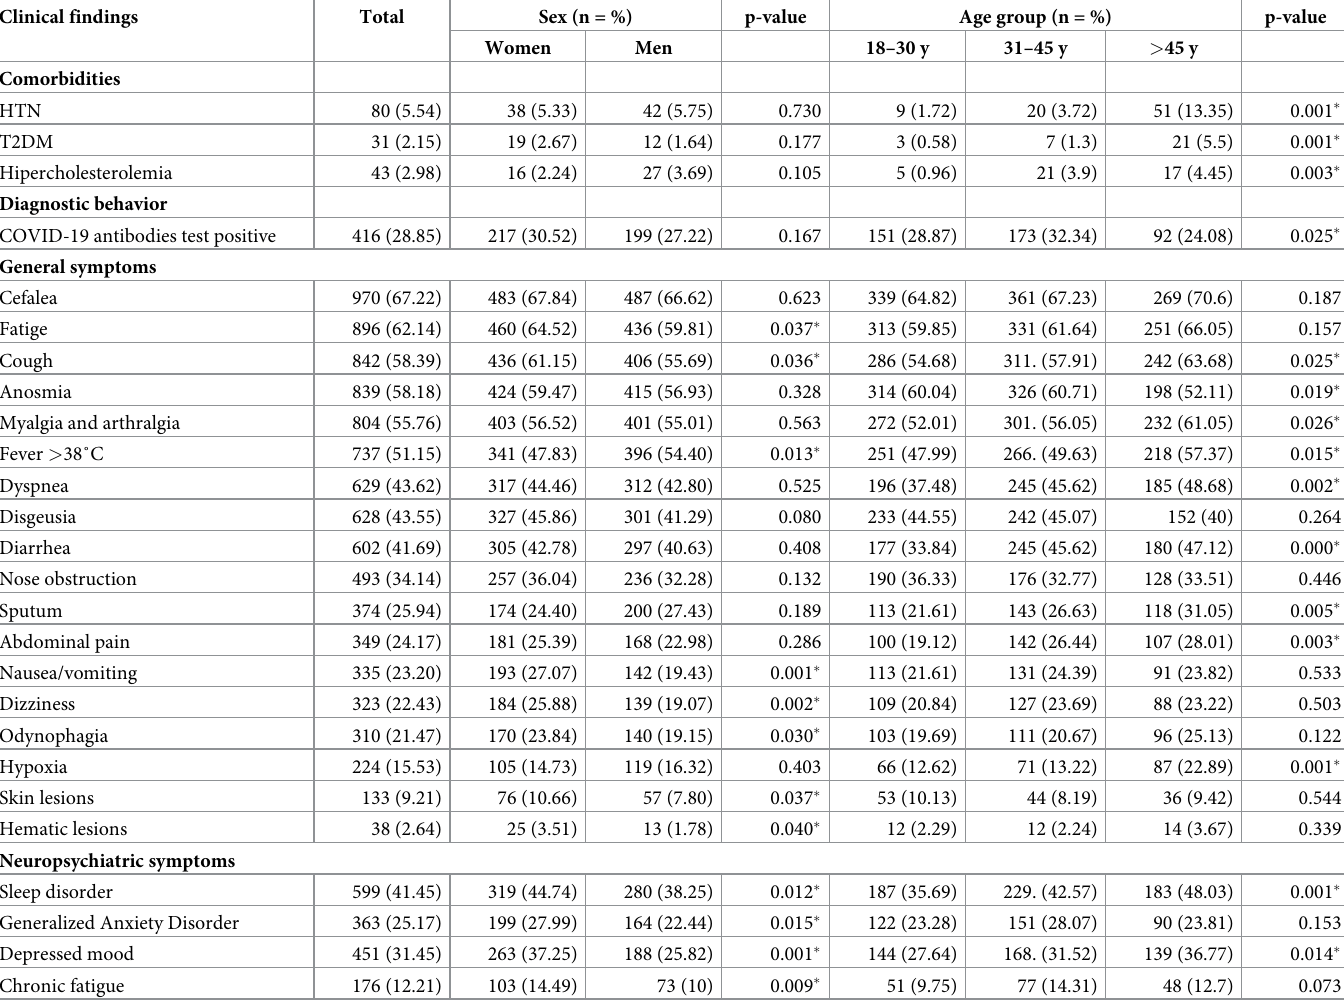
Table 1. Distribution of non-hospitalized patients infected with COVID-19 according to sex, age group, and clinical findings. Clinical